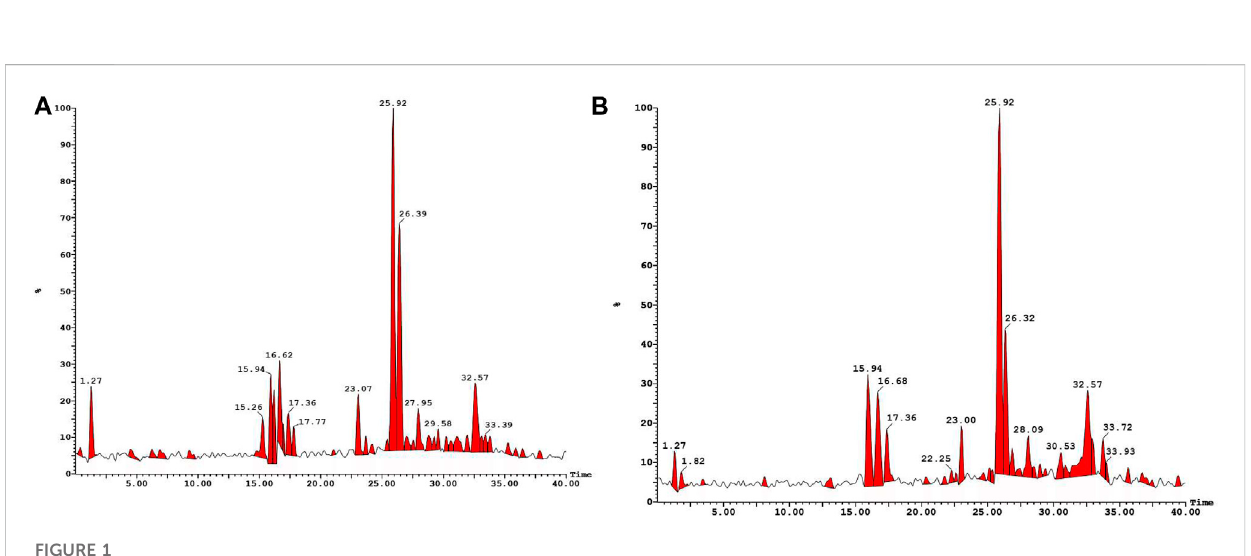
FIGURE 1 LC-MS (negative mode) traces of methanolic extracts of M1 (A) and M2 (B)